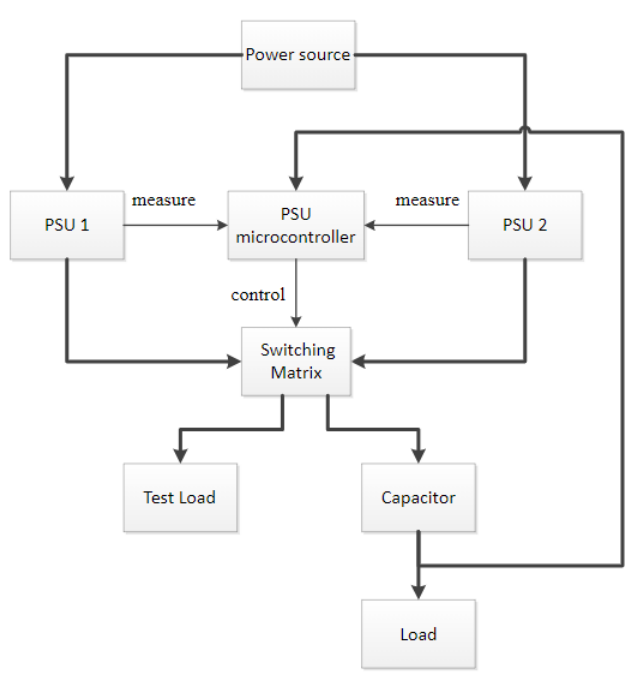
Figure 2. Redundant power supply structure with supervisor